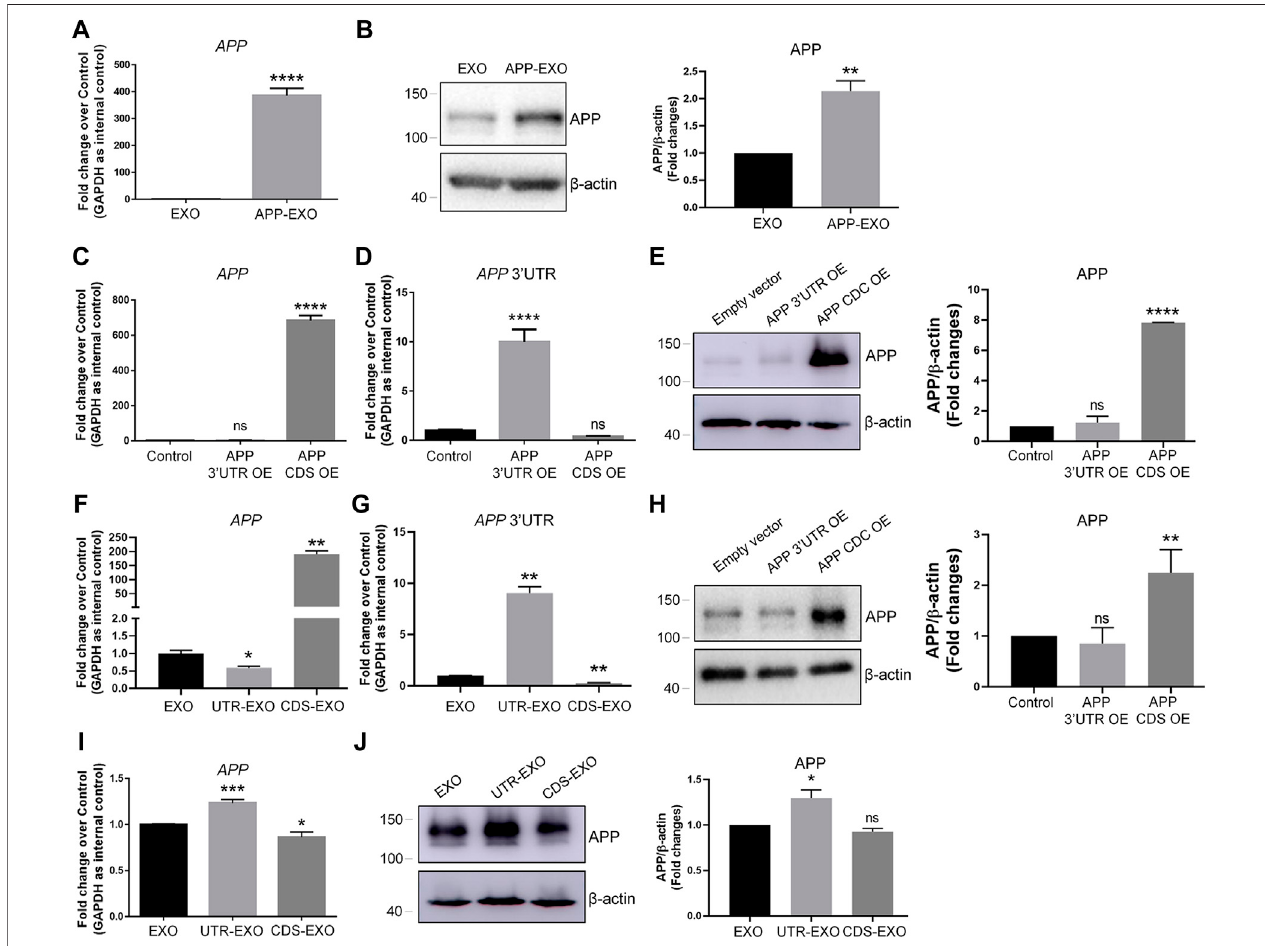
FIGURE 3 | APP-EXO promote APP expression in recipient cells independent to the direct delivery of APP gene products. (A,B) The expression levels of APP transcriptsand APPproteins inexosomes weredeterminedbyRT-qPCR (A) andwesternblotting (B) , respectively. (C,D) N2a cellswere transfected withempty control vector,APP3 ′ UTROEplasmid,orAPPCDSOEplasmidfor2 days.Theexpressionlevelsof APP transcripts (C) and AP P3 ′ UTR (D) weredetermined byRT-qPCR. (E) TheAPPproteinlevelsincontrol,APP3 ′ UTROE,andAPPCDSOEgroupsweredeterminedbywesternblotting. (F,G) Theexpressionlevelsof APP transcripts (F) and APP 3 ′ UTR (G) in EXO, UTR-EXO, and CDS-EXO were determined by RT-qPCR. (H,I) N2a cells were co-culture with EXO, UTR-EXO, or CDS-EXO for 2 days. The expression levels of APP transcripts (H) and APP proteins (I) were determined by RT-qPCR and western blotting, respectively. Data were represented as mean ± s. d. from three independent experiments. *, **, and **** denote p < 0.05, p < 0.01, and p < 0.0001, respectively. ns denotes no signi fi cance.